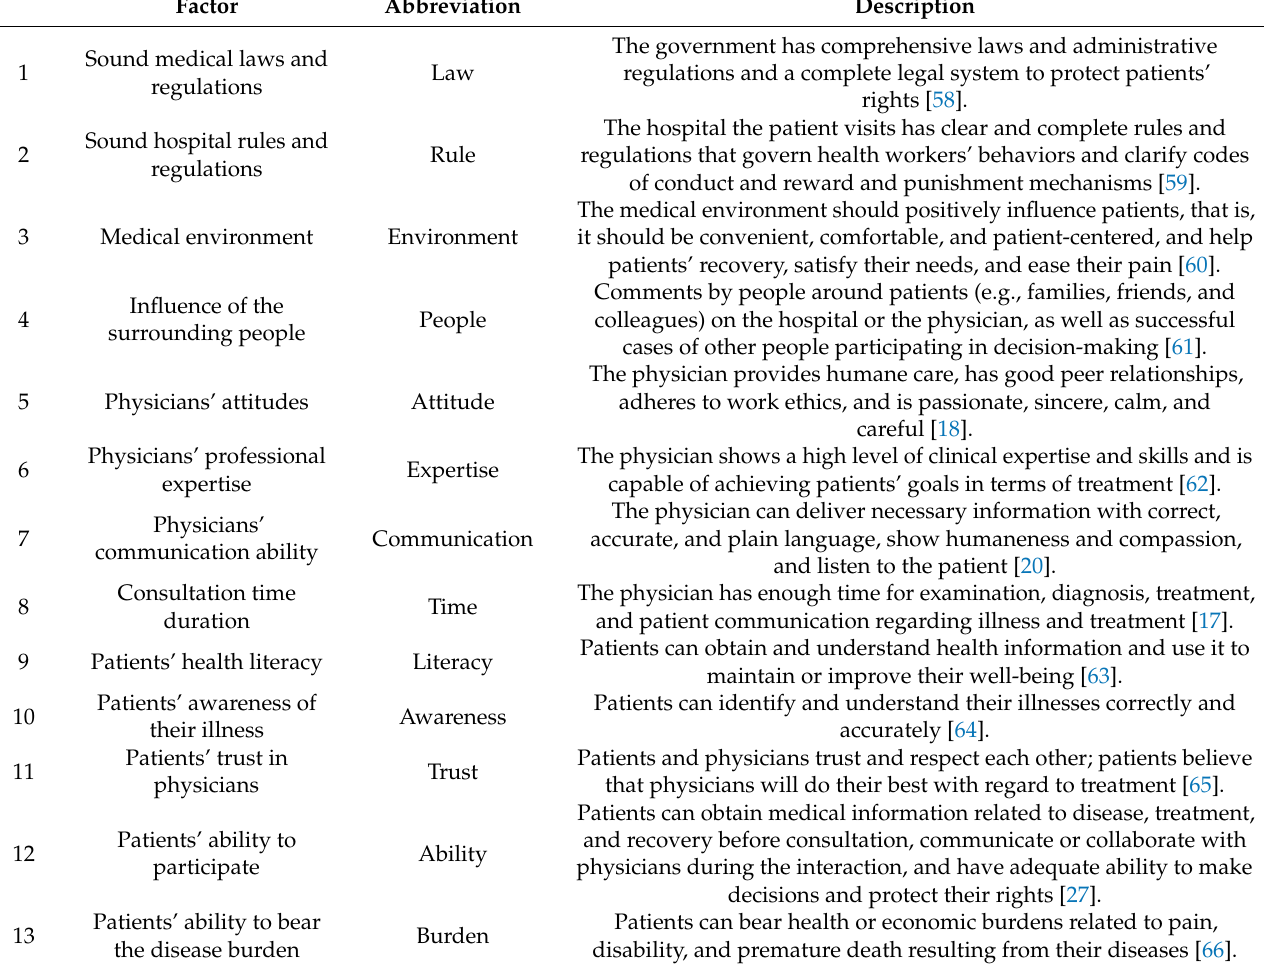
Table 1. List of factors and